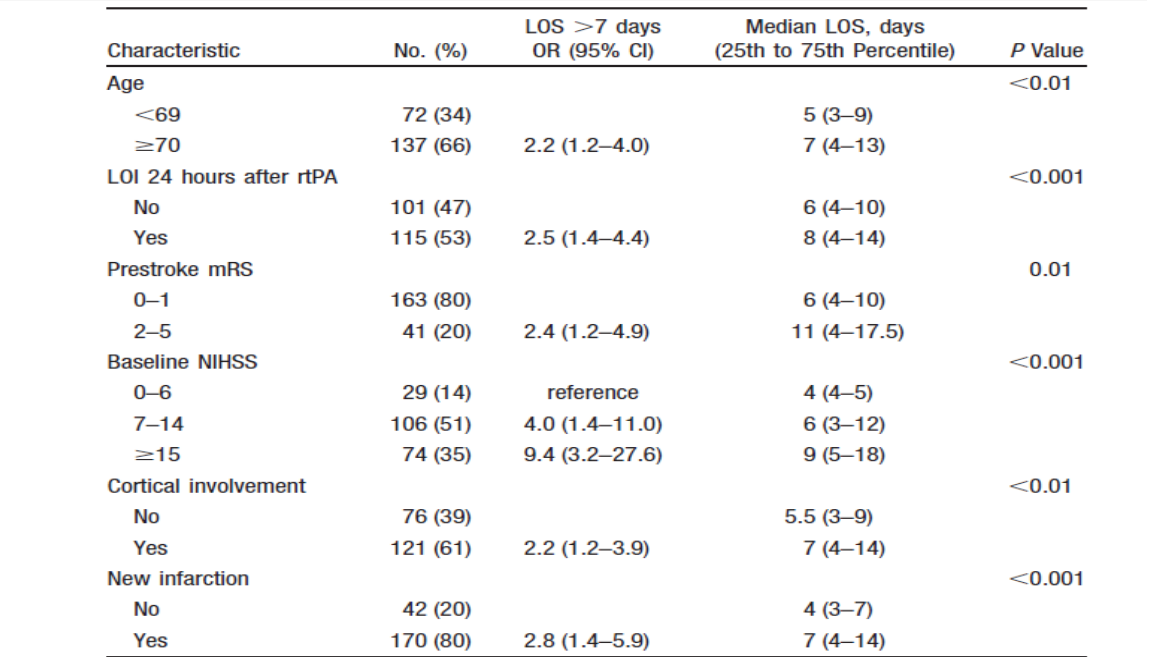
Table 2. Univariate Analysis of Predictors for